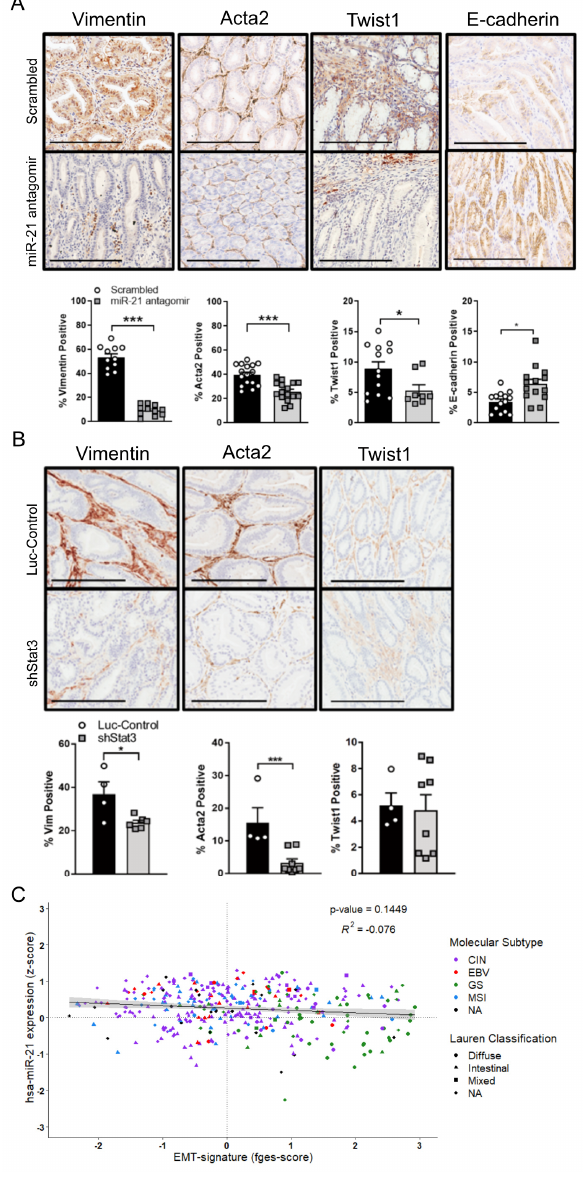
Figure 6. miR-21 inhibition suppresses the expression of EMT markers in Stat3-dependent GCs. ( A ) Representative IHC stains for Vimentin, Acta2, Twist1 and E-cadherin on cross-sections of adenomas collected in 12-week old Gp130 F/F mice after the end of a 4-week treatment period with the scrambled control or miR-21 antagomir. The quantification of the staining was performed by ImageScope analysis software. ( B ) Representative IHC stains for Vimentin, Acta2 and Twist1 on cross-sections of adenomas from 18-week old Gp130 F/F ; shStat3 ; rtTA and Gp130 F/F ; shLuc ; rtTA mice 2 weeks after DOX treatment. The quantification of the staining was performed using ImageScope analysis software. ( C ) Correlation analysis of miR-21 (z-score) with the “EMT-signature” functional gene signature (fges) using the TCGA STAD dataset. Each dot represents a single cancer, indicating both its molecular subtype and Lauren classification. The data are presented as the mean ± SEM, with each point representing an individual mouse. * p < 0.05; *** p < 0.001. Scale bar = 200 µm.